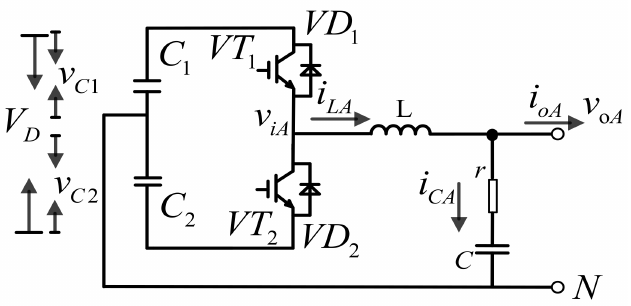
Figure 4. Equivalent single-phase inverter circuit.